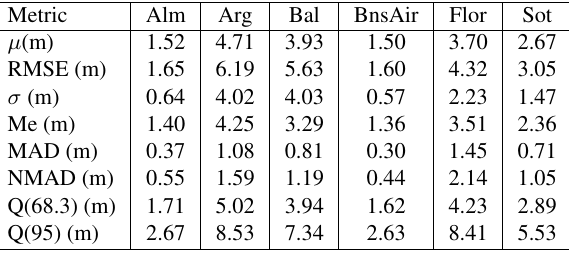
Table 6: Metrics of precision for the asymmetrical precision of road axes